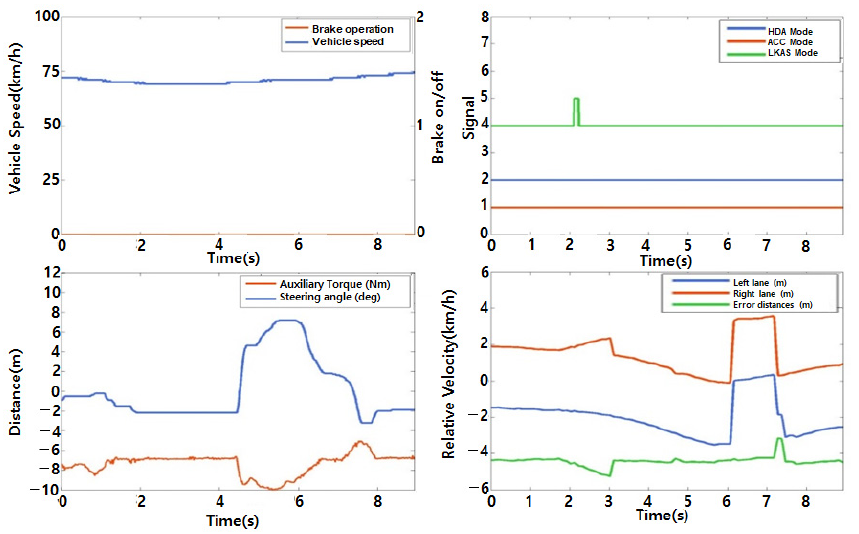
Figure 8. Preliminary data analysis for case 5.